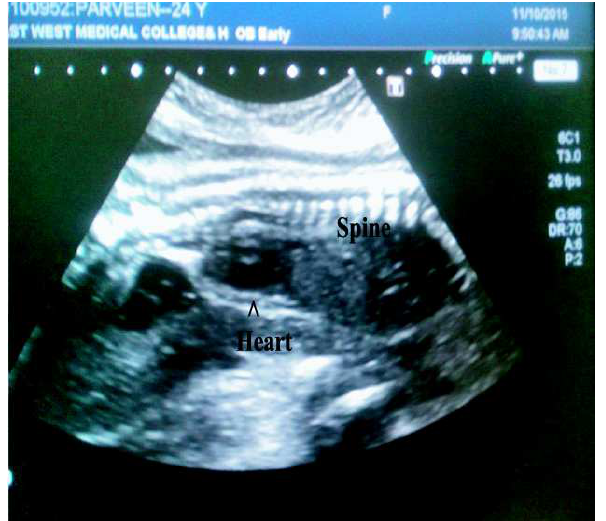
Fig 2. Antenatal ultrasonography showing